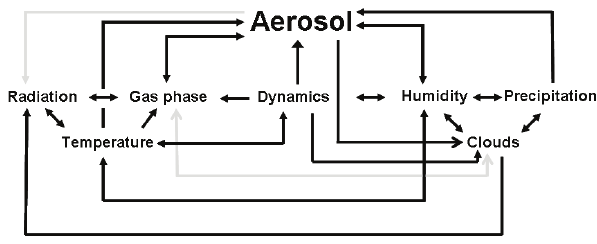
Fig. 1. Feedback mechanisms considered in COSMO-ART. Grey arrows indicate feedbacks that are neglected in this study.